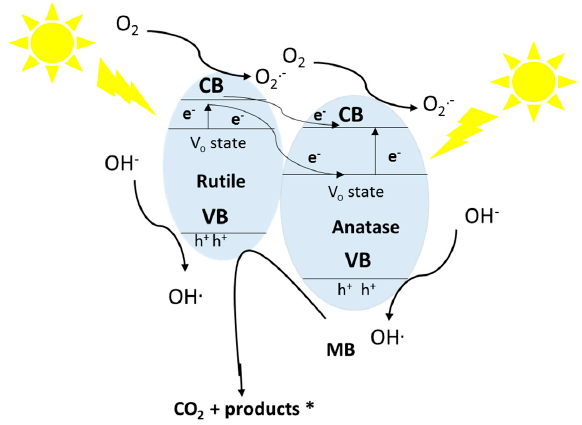
Figure 9. The photo-excited electrons-transfer under the simulated sun light irradiation for V-400 and H-400.